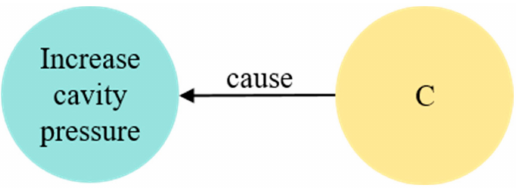
Figure 17. Case 2.